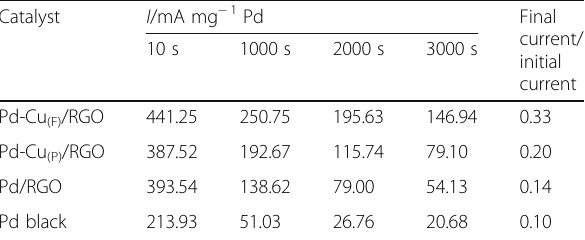
Table 1 Peak current densities of various catalysts in 0.5